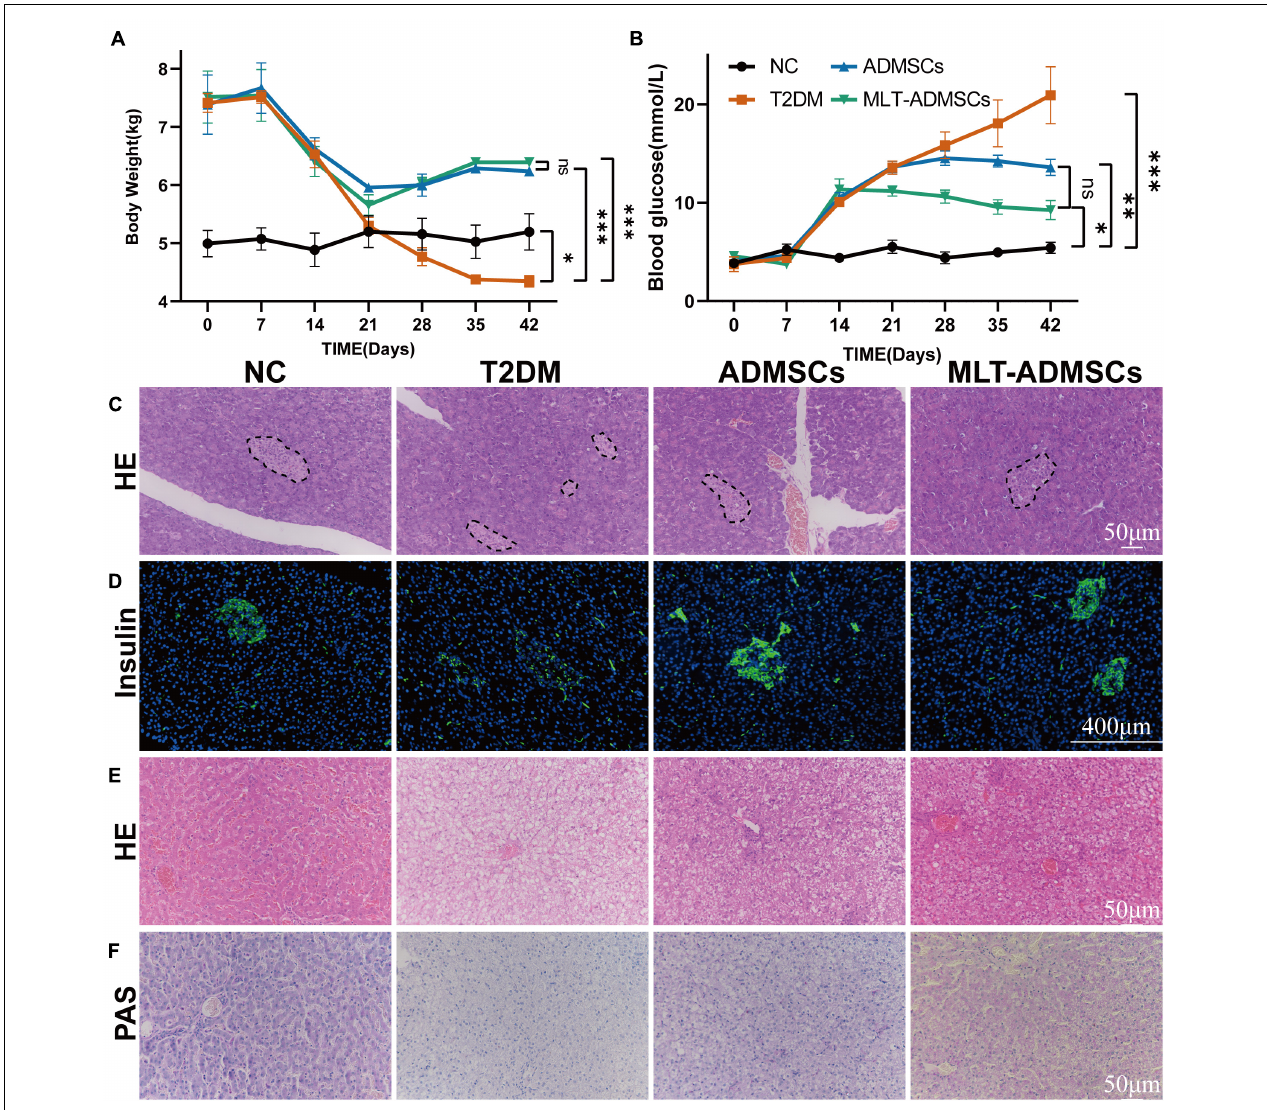
FIGURE 7 | MLT promotes the therapeutic effect of ADMSCs in canine DM. (A) Weight changes. (B) Random blood glucose changes. (C) Islet H&E staining. (D) Insulin immunofluorescence staining. (E) Liver H&E staining. (F) Liver PAS staining. Values in this figure are the mean ± SE; n = 3 per group; ns > 0.05, ∗ p < 0.05, ∗∗ p < 0.01, ∗∗∗ p < 0.001 determined by a repeated-measures ANOVA. The dotted ellipse includes the location and size of the